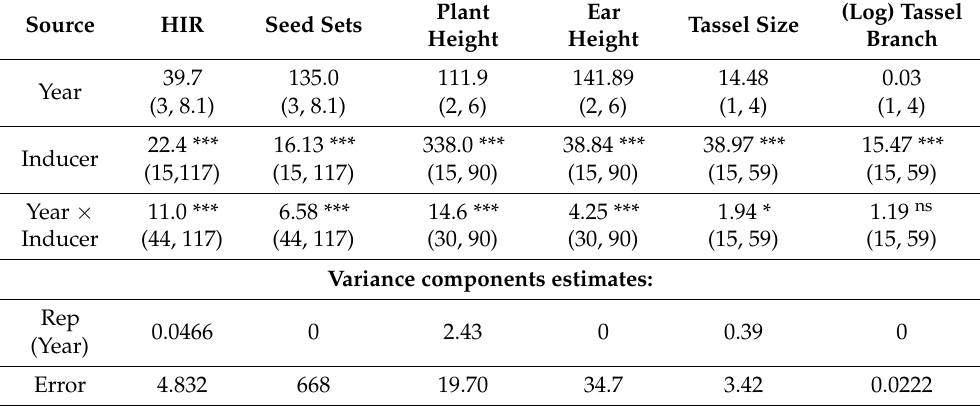
Table 1. Analysis of variance across years between 2016 and 2018. F-ratios are shown for each source along with the numerator and Kenward-Roger adjusted denominator degrees of freedoms (in